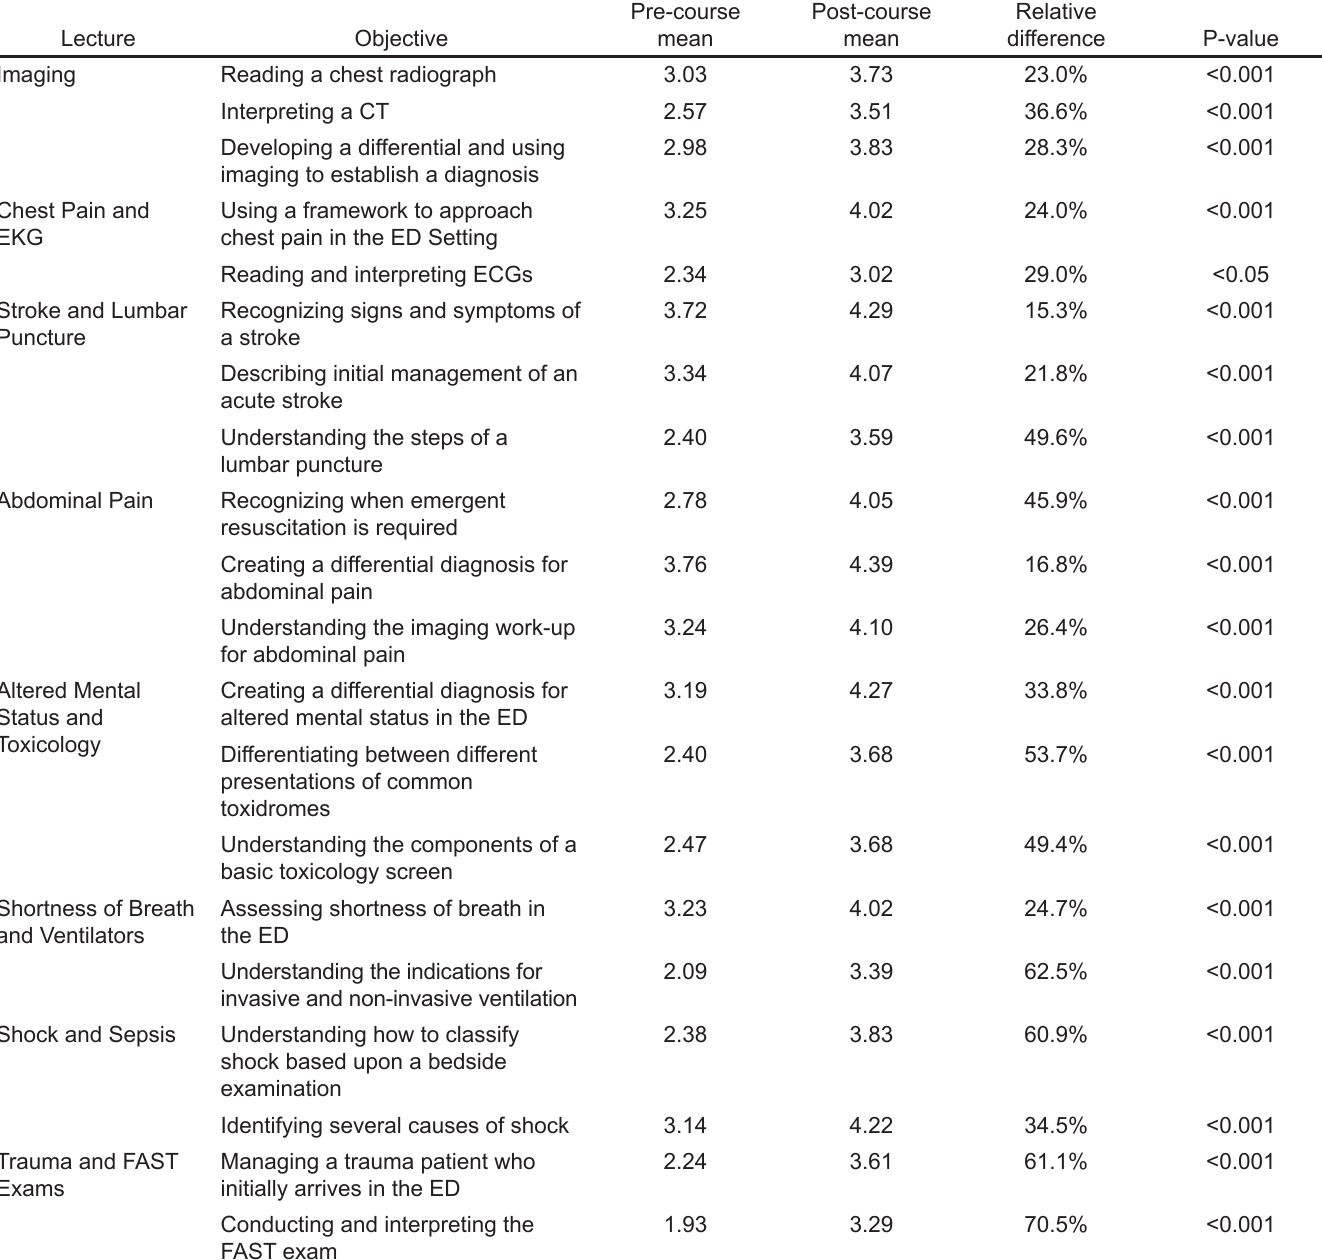
Table 1. Pre-course and post-course assessment of comfort with learning objectives in an online emergency medicine course led by